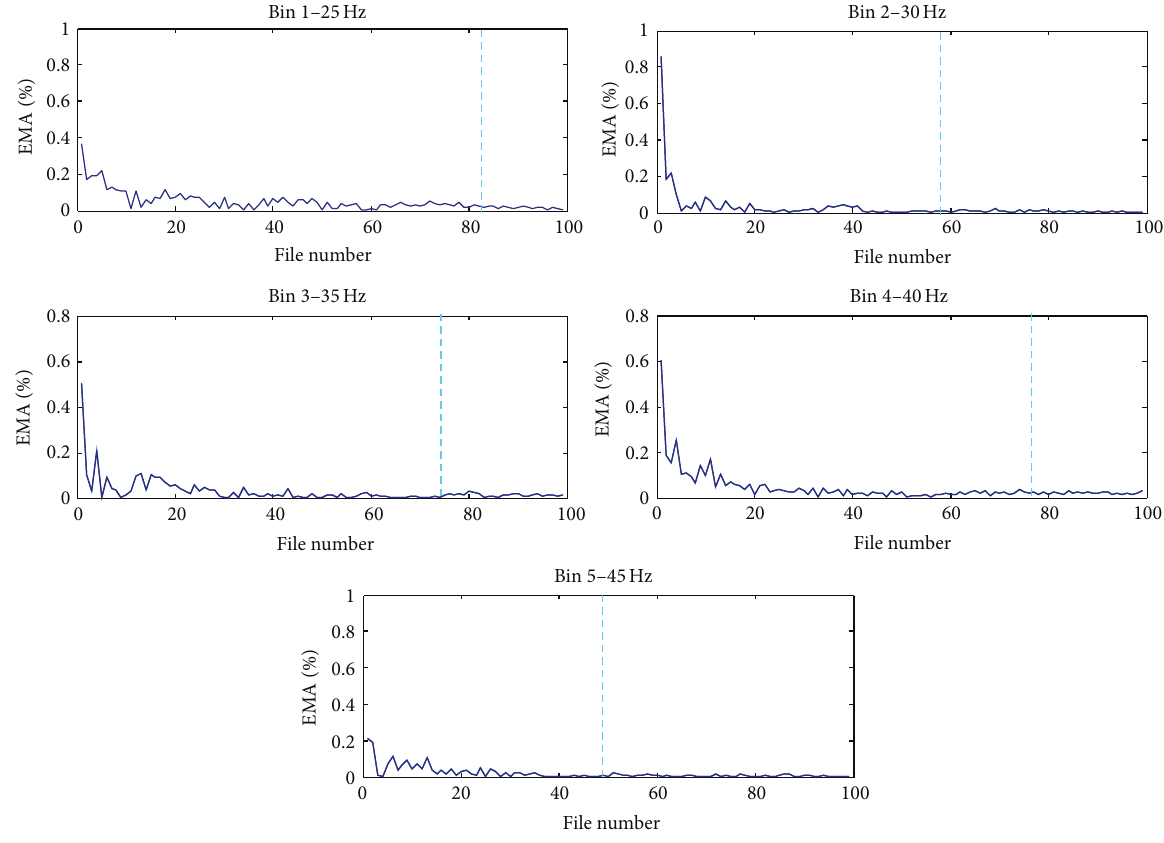
Figure 8: Vibration data convergence.